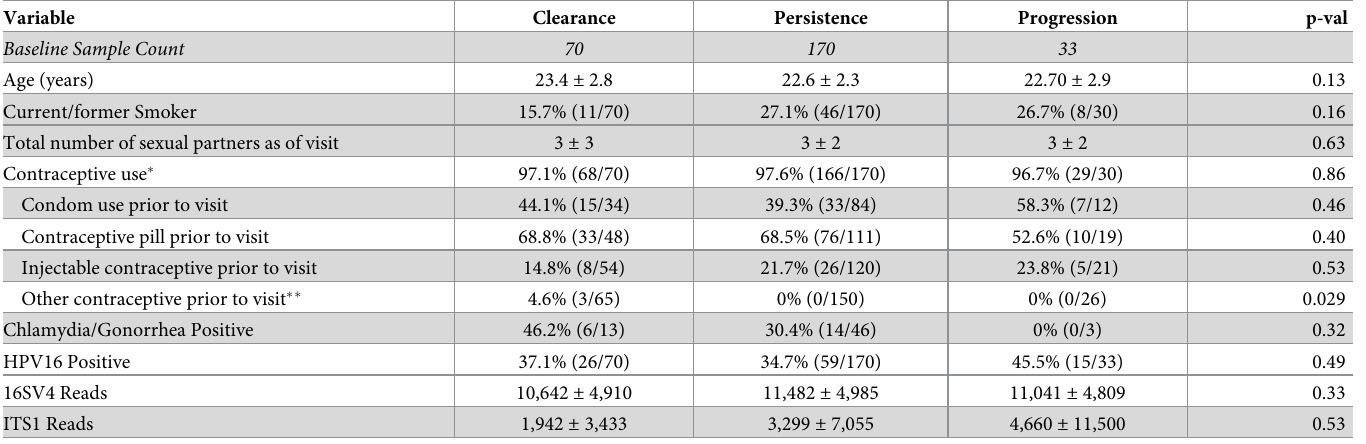
Table 1. CVT cohort